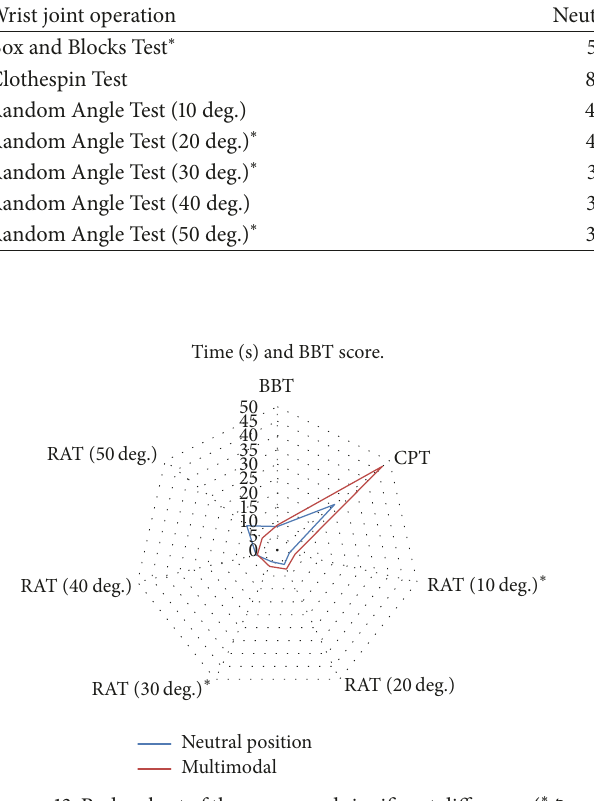
Figure 13: Radar chart of the means and significant difference ( ∗ 𝑝 < 0.05 , 𝑁 = 4